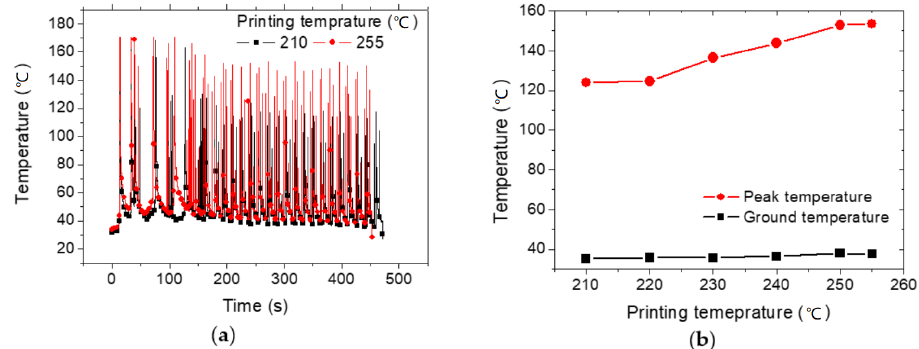
Figure 5. Quantitative infra-red results: ( a ) Thermal cycling for two different printing temperatures; ( b ) Average ground and peak temperatures for all printing conditions.